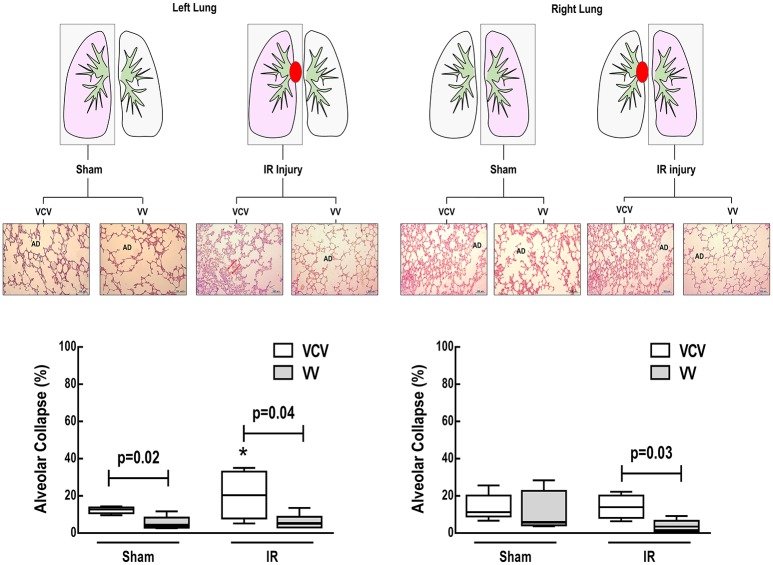
Schematic representation of lung ischemia-reperfusion (IR) injury and sham clamping in left (injured) and right (contralateral) lungs, in animals ventilated in volume-controlled (VCV) or variable controlled ventilation (VV). AD: Alveolar duct. Photomicrographs of lung parenchyma stained with hematoxylin-eosin, original magnification x200. Arrows: alveolar collapse. Fraction areas of alveolar collapse in left and right lungs of Sham and IR animals ventilated with VCV and VV. Values represent medians and whiskers represent the 10–90 percentile range of 6 animals in each group. Two-way repeated-measured ANOVA followed by Bonferroni's post-hoc test (p < 0.05). *Significantly different from Sham group (p < 0.05).